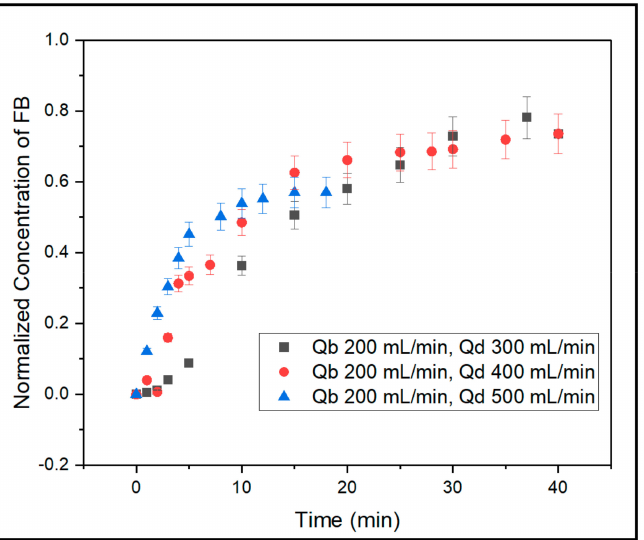
Figure 5. ( a , b ) Variation in TMP during simulated dialysis session (Qb = 200 or 400 mL/min; Qd = 400 or 500 mL/min).